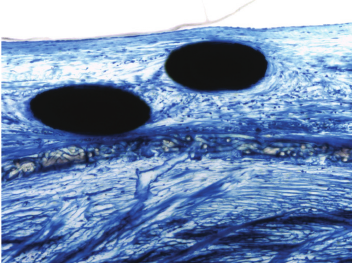
Figure 5: Micrograph of metal struts of the occluder (black) on the right atrial side. The struts are completely covered by fibrous tissue and endothelium. Magnification 100 × , Richardson blue staining.